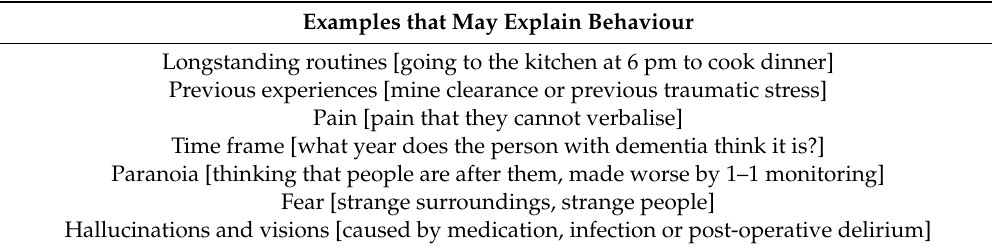
Table 4. Example reasons for disruptive actions by